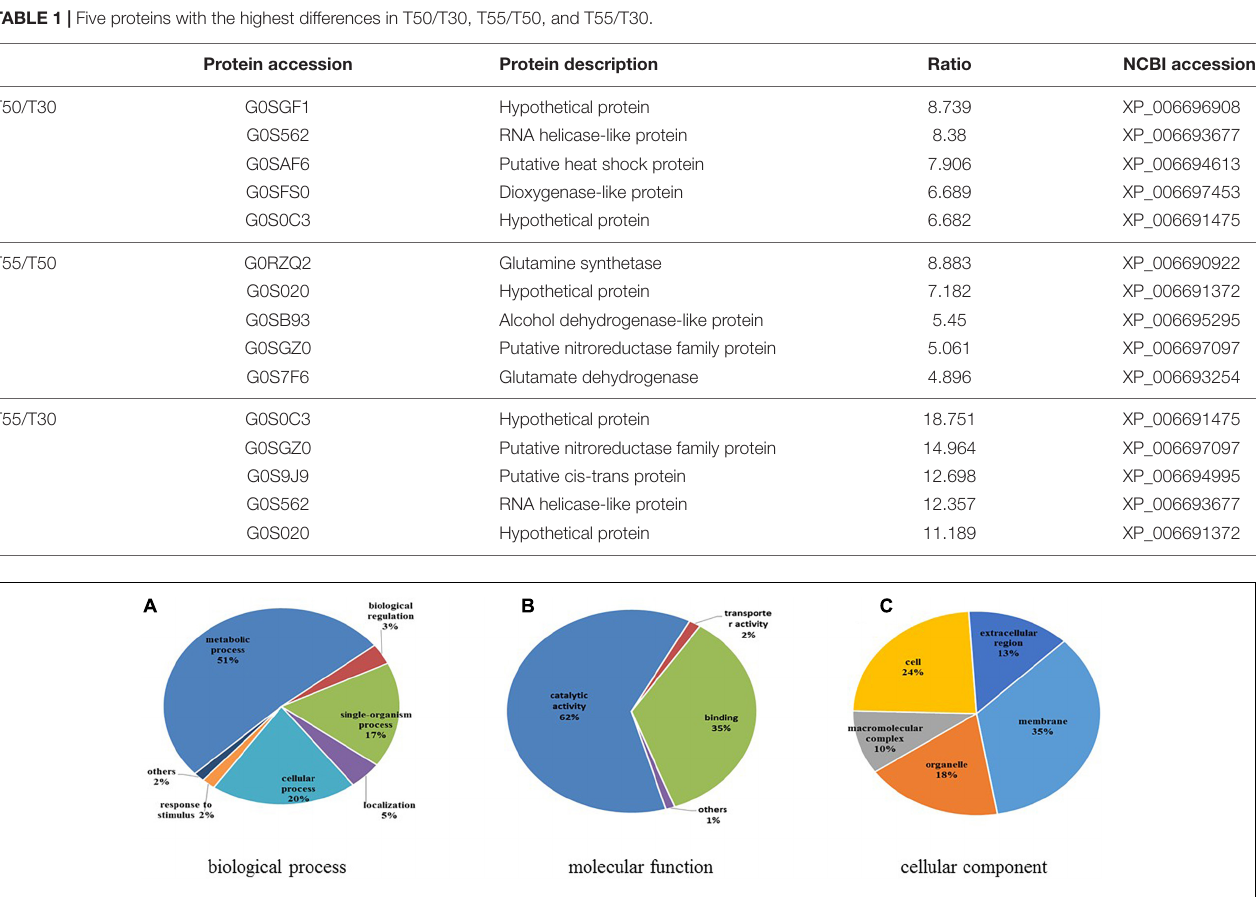
FIGURE 8 | Functional classification of differentially expressed N-glycoproteins. (A) Classification based on biological process. (B) Classification based on molecular function. (C) Classification based on cellular component.